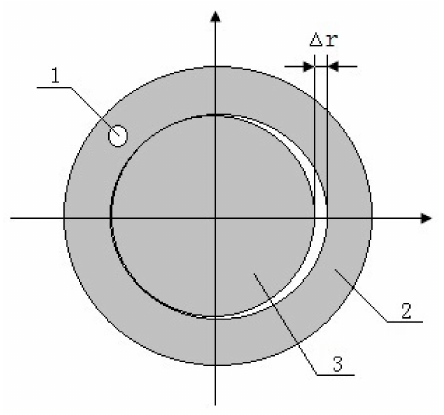
Figure 6. The deriving principle of additional unbalance. Notes: 1 unbalance mass; 2 balance disk; 3 spindle; ∆ r offset distance.